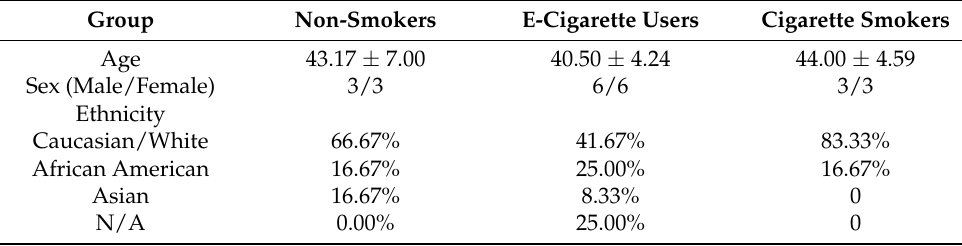
Table 2. Patient information for